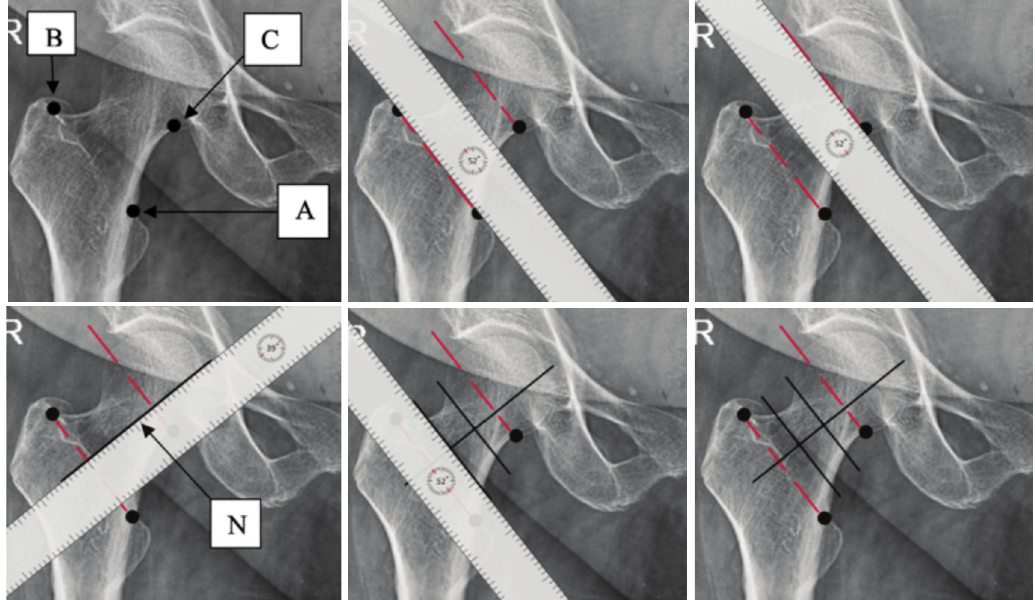
Illustration depicting method applied in dividing the neck of femur into three anatomical zones. Fig. 3: